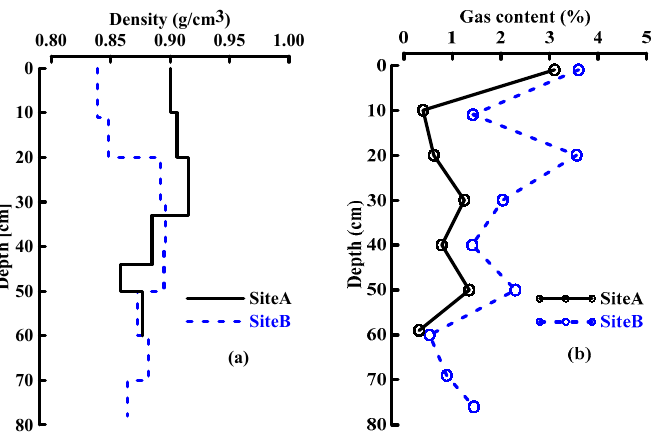
Figure 7. Vertical profiles of density ( a ) and gas content ( b ) for ice cores collected on 15 February 2014.